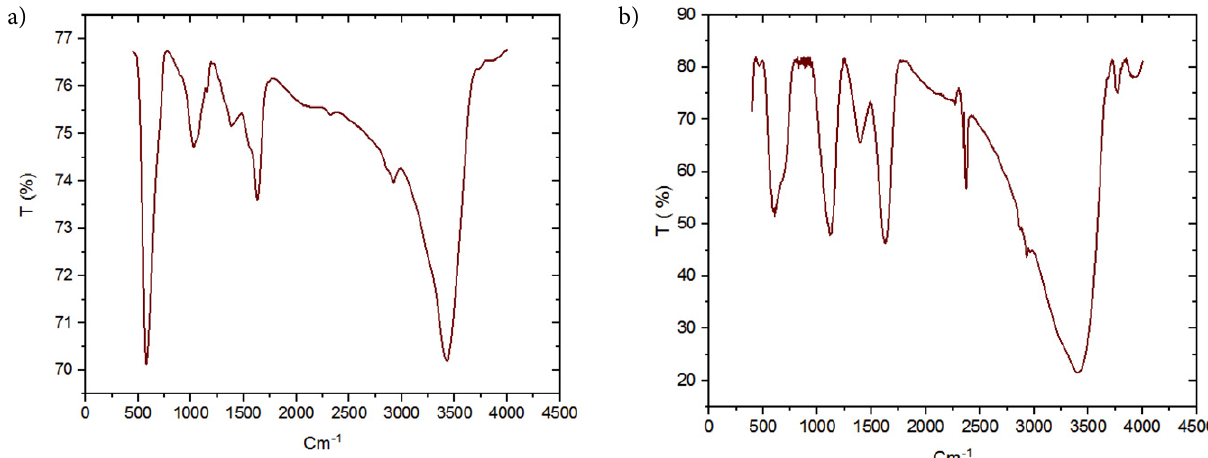
Figure 1. Fourier transform infrared spectroscopy (FTIR) spectra of a ( Mn / GO / CS/ A. sativum / Que ) b ( GrMn / GO / CS / A. sativum / Que)